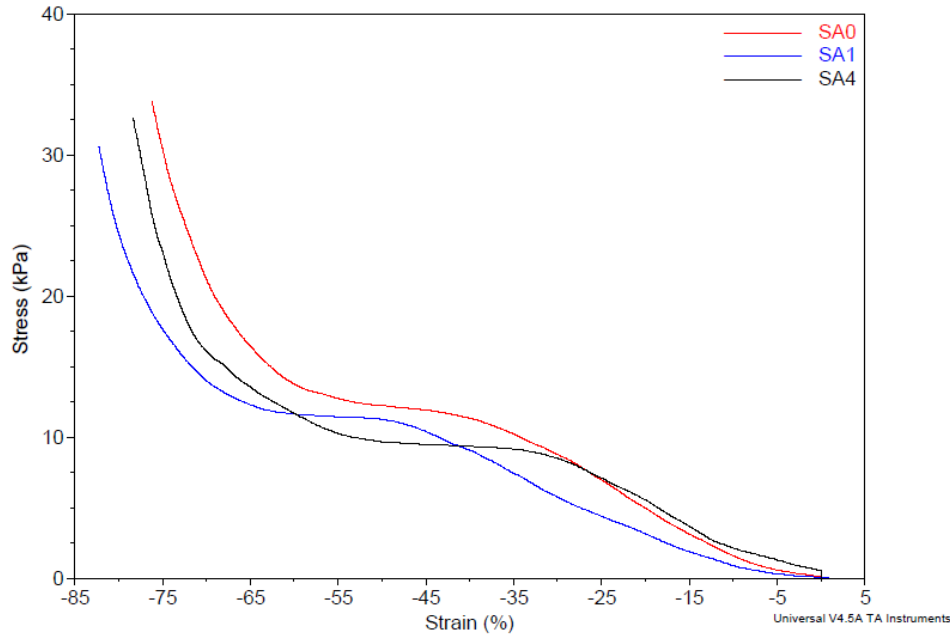
Figure 7. Stress – strain curves of the equilibrium-swelled hydrogel samples.